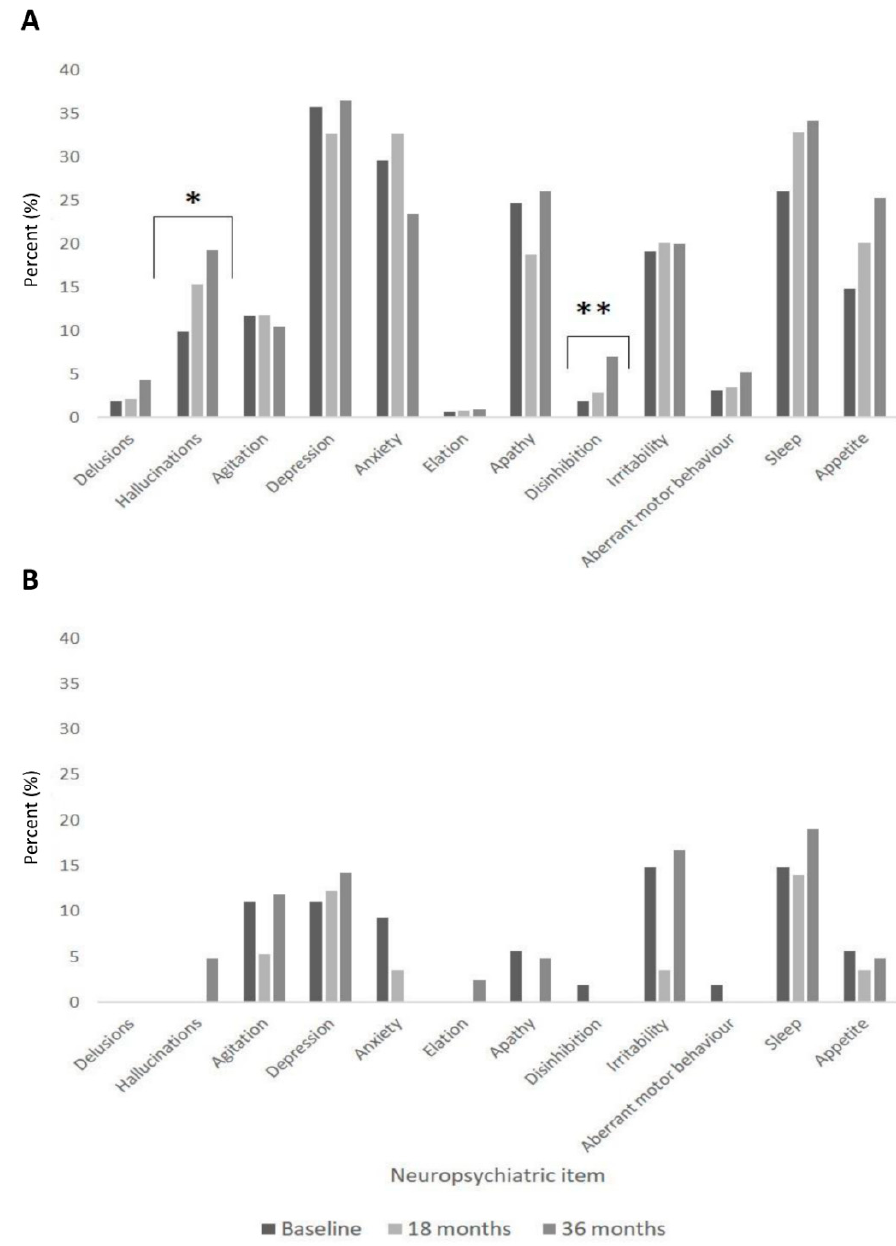
Figure 2. Progression of neuropsychiatric symptoms over time in PD ( A ) vs. controls ( B ) .